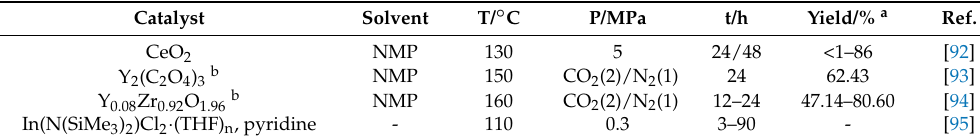
Table 3. Metal-catalyzed carbonylation of amines and CO 2.